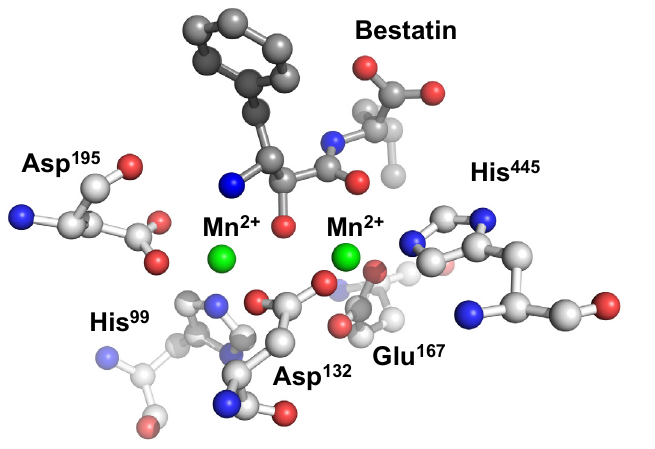
Figure 7. Active site of human CN2 crystallized with the inhibitor bestatin. The manganese(II) ions of the di-nuclear complex species are represented as green